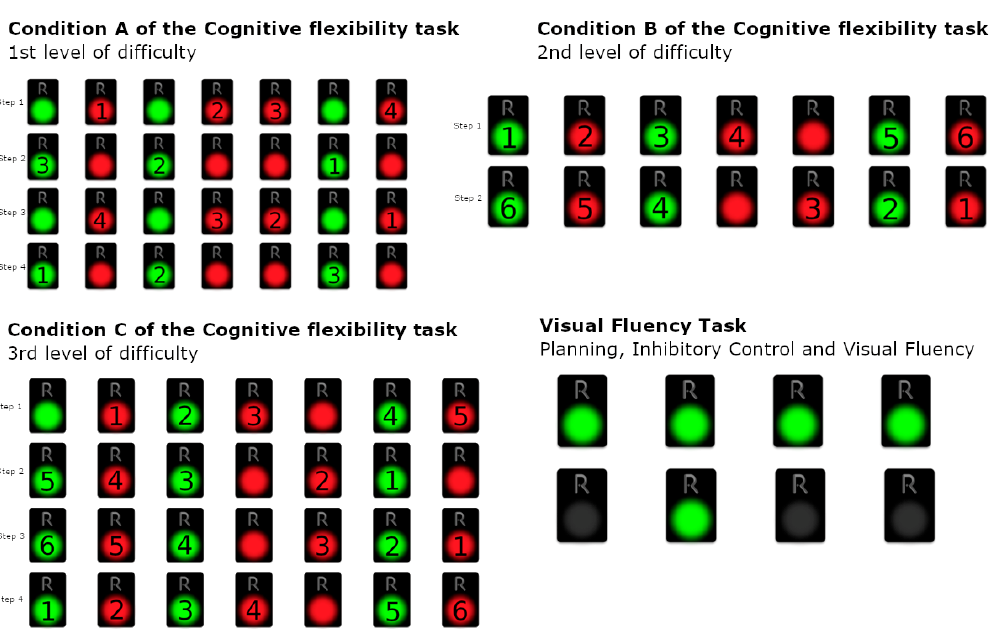
Figure 2. Condition A–C of the Cognitive Flexibility Task—1st, 2nd, and 3rd levels of difficulty and Visual Fluency Task (Planning, Inhibitory Control, and Visual